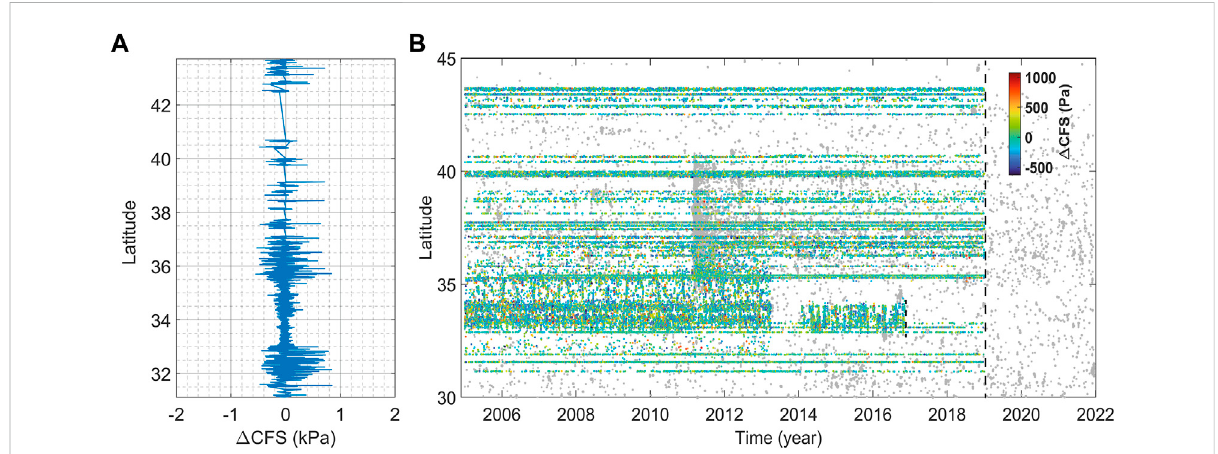
FIGURE 6 Seismicity and stress produced by solid-Earth tides in Japan. (A) Temporal average Δ CFS for the occurrence of LFEs between 2005 and 2021 as a functionof latitude[datafromIdeharaetal. (2014);Supinoetal. (2020)]. (B) Temporalevolutionof LFEs(pointsarecoloredaccordingto thevalueof Δ CFS).